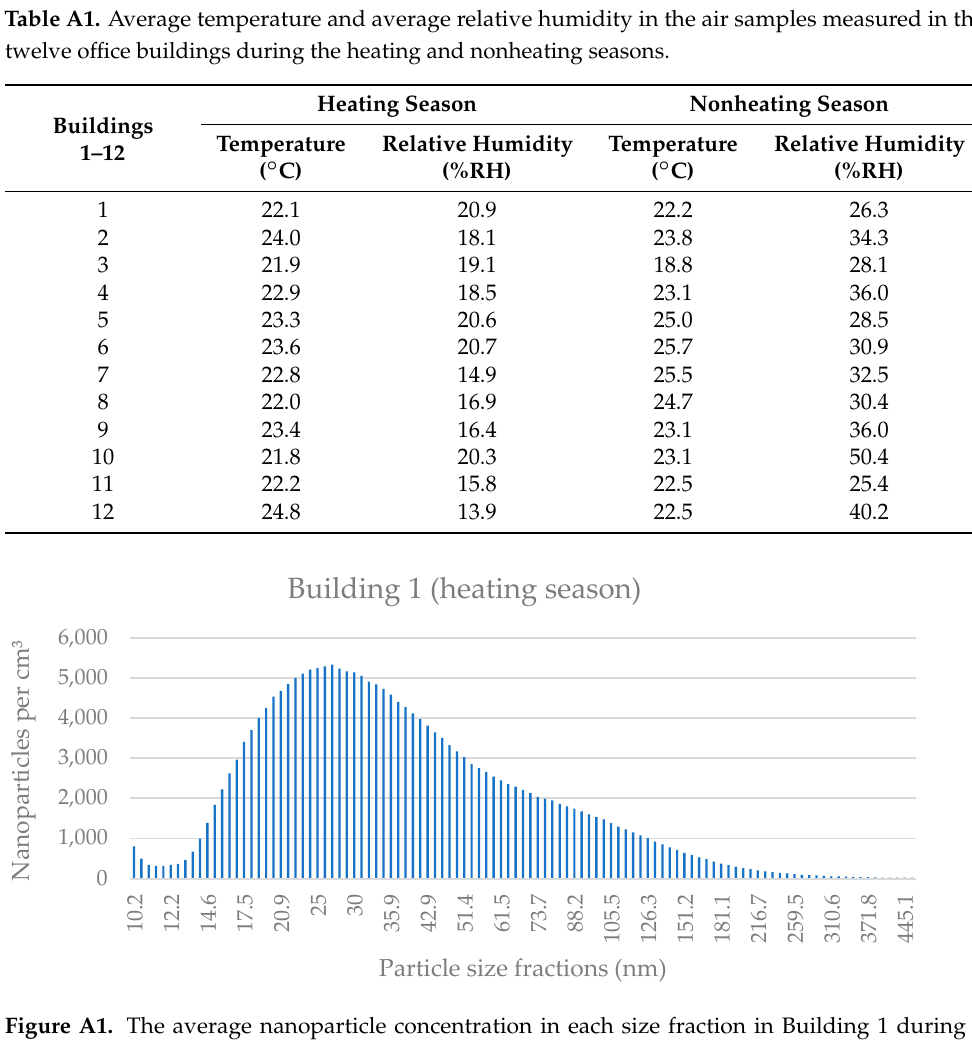
Figure A2. The average nanoparticle concentration in each size fraction in Building 1 during a one- week measurement period during the nonheating season. Figure A3. The average nanoparticle concentration in each size fraction in Building 2 during a one- week measurement period during the heating season.